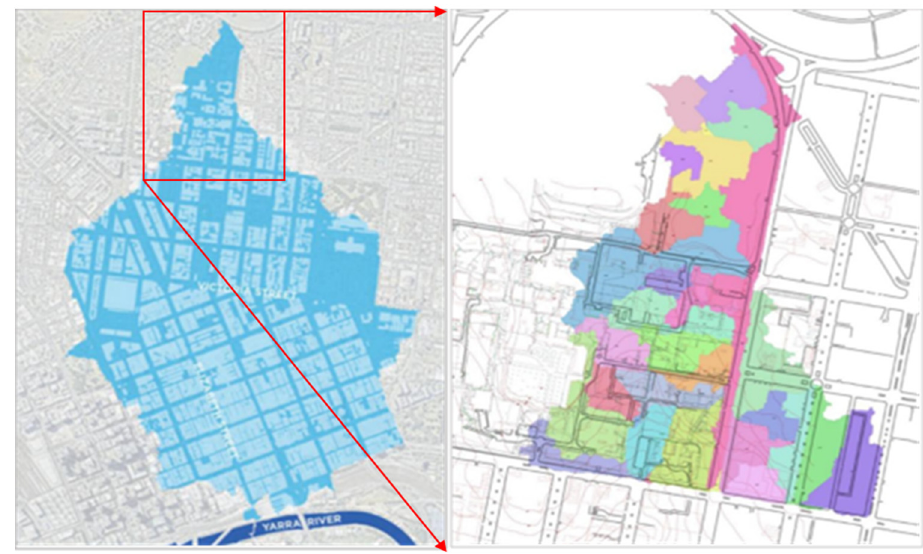
Figure 2. Elizabeth St. Catchment in blue ( left ) and The University of Melbourne Parkville Sub catchments shown in different colours ( right ), also shown by red boundary on the left.